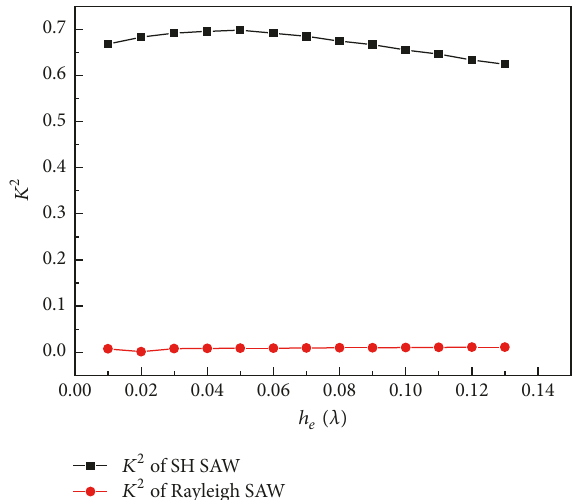
Figure 7: Estimated 𝐾 2 values (as a function of ℎ 𝑒 ) of the SH and Rayleigh